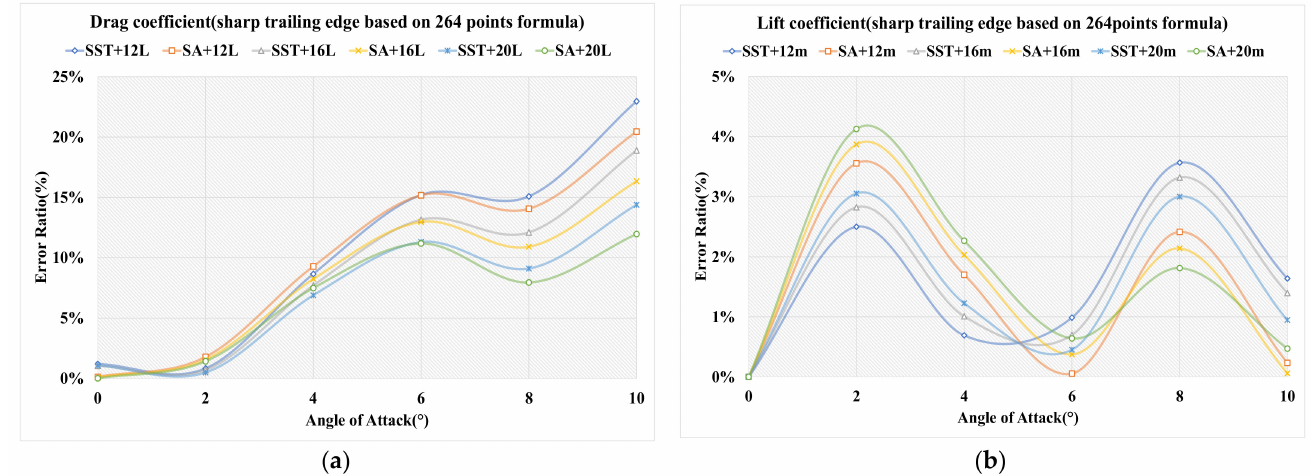
Figure 10. ( a ) Drag coefficient of sharp trailing edge based on 264 points formula; ( b ) lift coefficient of sharp trailing edge based on 264 points formula.